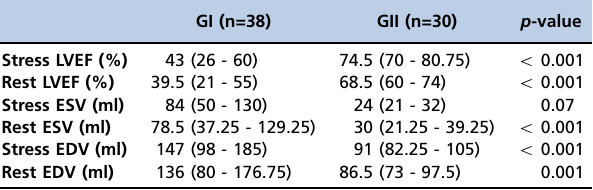
Table 4 - Results of the comparison of left ventricle ejection fraction between GI and GII. GI (n=38) GII (n=30)